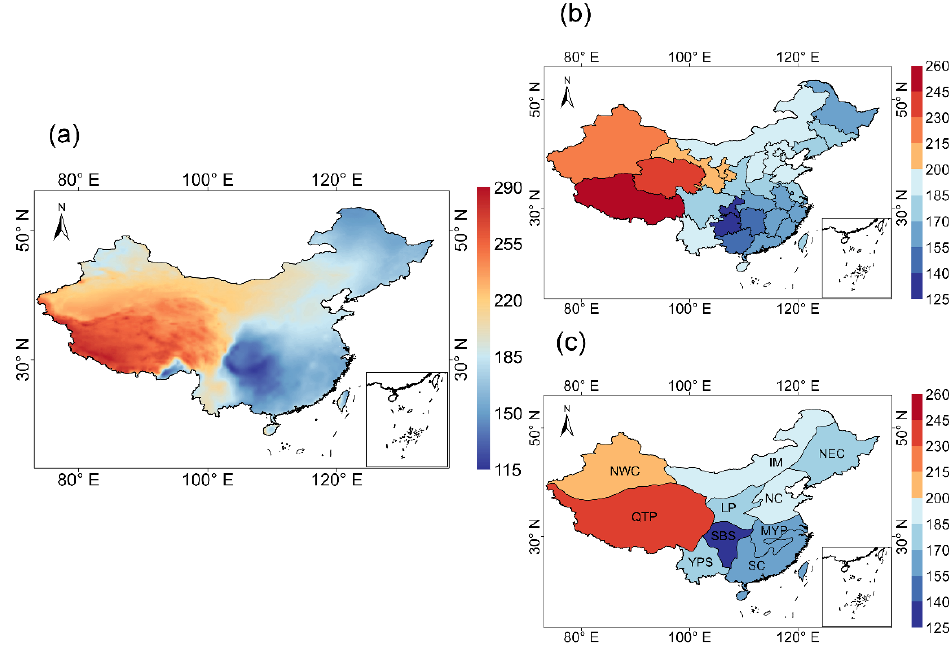
Figure 2. Annual average spatial distribution of POAI (Wm − 2 ) in China from 2010 to 2020. ( a ) is the annual average spatial distribution of POAI. ( b ) the same as ( a ) but for each province. ( c ) the same as ( a ) but for each geographical region.